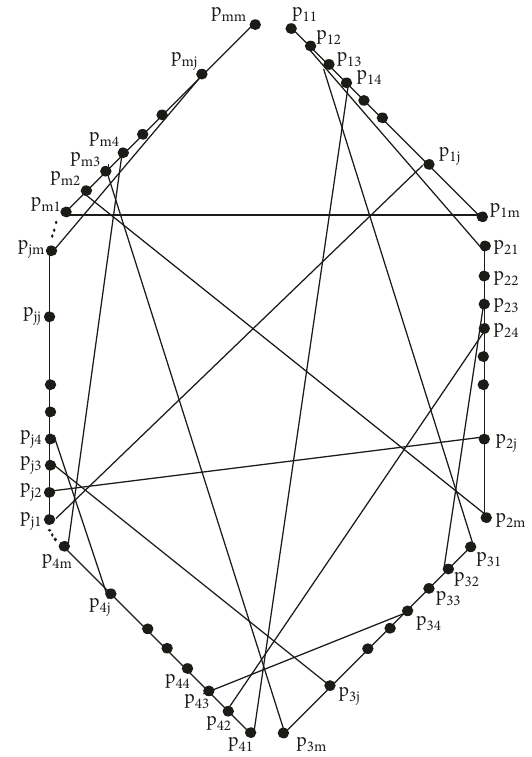
Figure 2: Graph of swapped OTIS OP